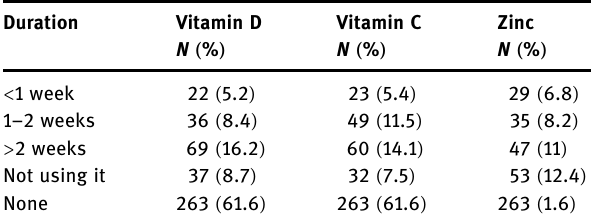
Table 6: Duration of use of prophylactic dietary supplements